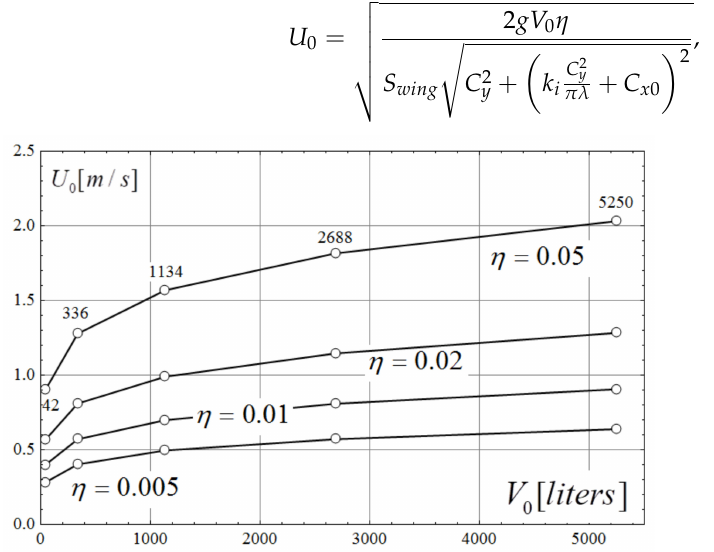
Figure 4. Speed on the trajectory versus the volume of the BRW type vehicle for different magnitudes of relative differential buoyancy η ( C y = 0.3).